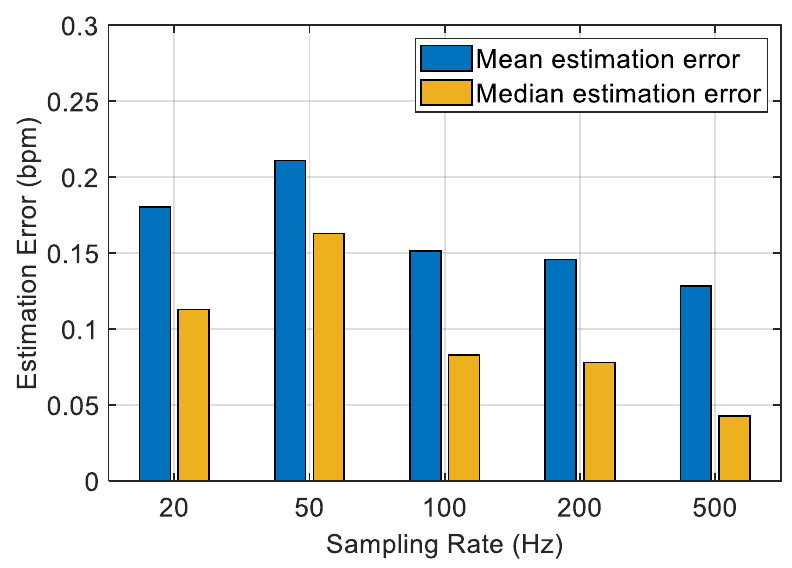
Figure 15. Impact of sampling rate.